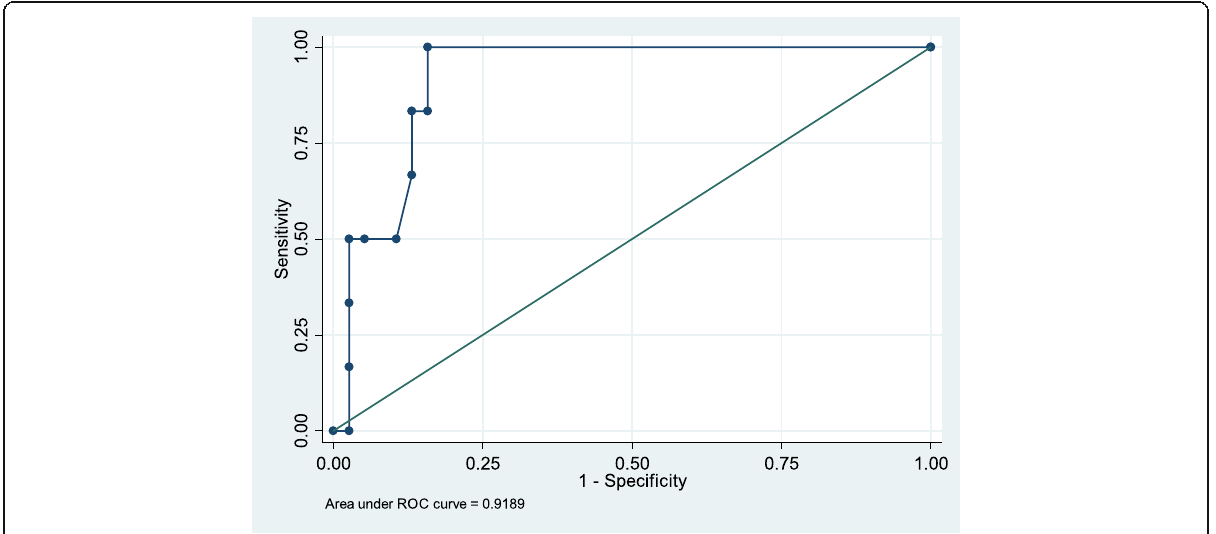
Fig. 3 The chest radiographic score at presentation is a strong independent associated factor for mortality. The area under the curve is obtained as 0.92, and cut point 0.48 of the chest radiographic score at presentation discriminates mortality with sensitivity 100% and specificity